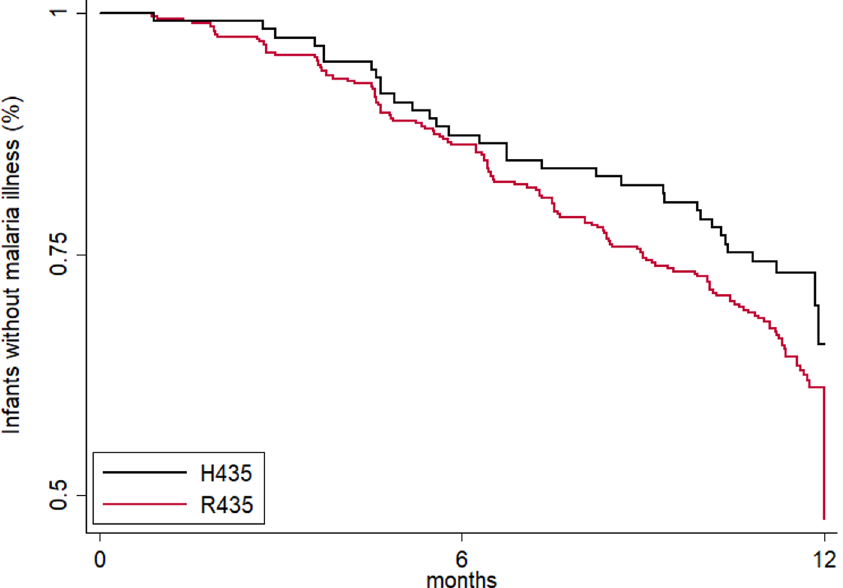
Fig 4. Maternal IgG3-H435 polymorphism is associated with a decreasedrisk of symptomatic malaria in infants from birth to 12 months of age. The time to first symptomatic malaria episodeduringinfancy is shown. The log-rankanalysisyielded p = 0.102. The Cox proportional hazard analysisadjustedfor malaria exposureand placentalmalaria gave a hazardratio of 0.69 (95% CI 0.46, 1.05, p = 0.083).